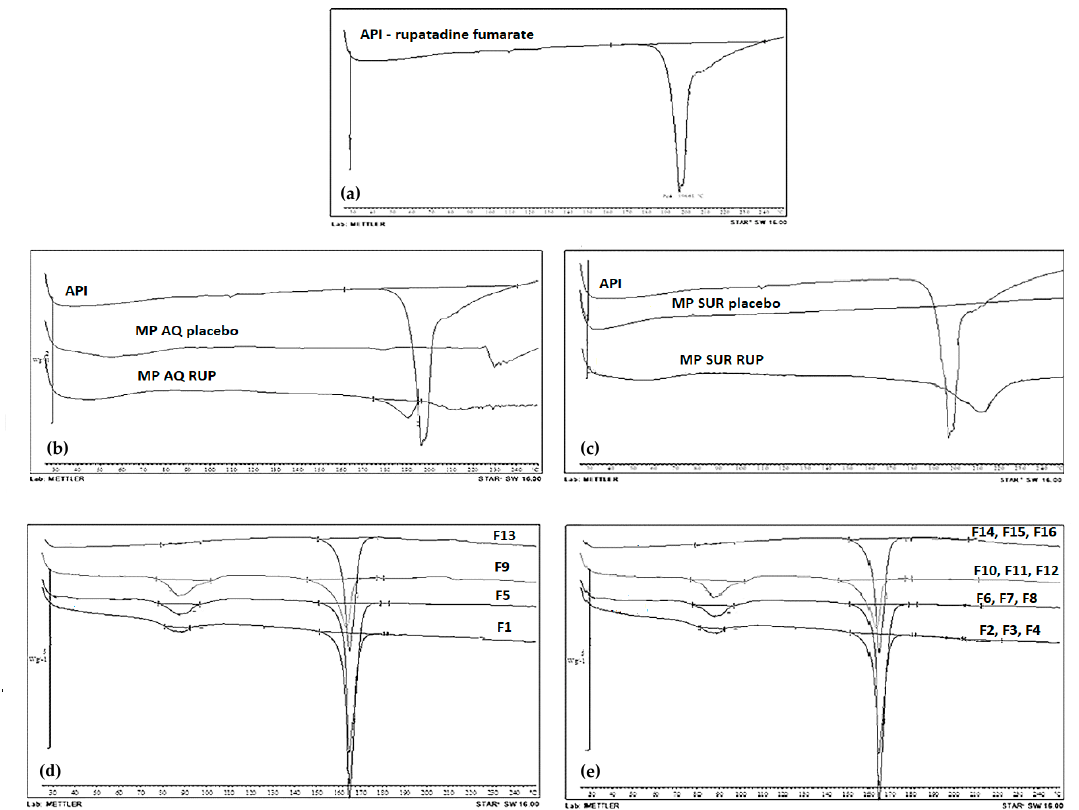
Figure 4. DSC thermograms of RUP - rupatadine fumarate ( a ), microparticles placebo obtained with Aquacoat ® or Surelease ® (MP AQ placebo, MP SUR placebo) and with RUP (MP AQ RUP, MP SUR RUP) ( b,c ), ODMT placebo (F1, F5, F9, F13) ( d ), ODMT with pure RUP (F2, F6, F10, F14) and with RUP enclosed in microparticles (F3, F4, F7, F8, F11, F12, F15, F16) ( e